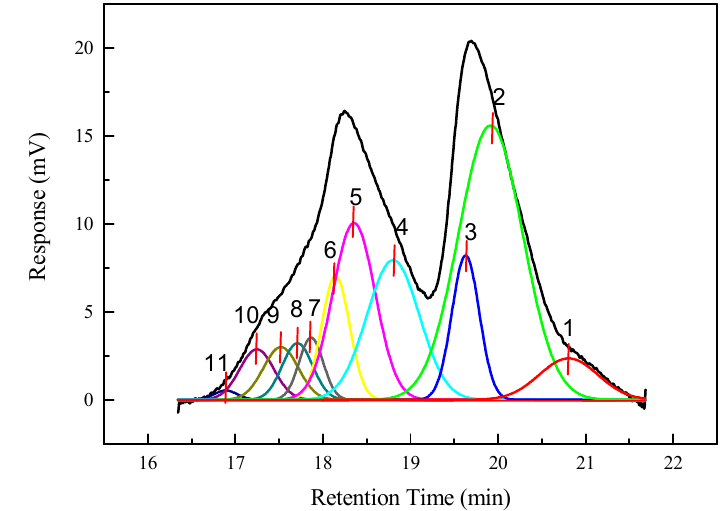
Figure 7. Gas permeation chromatograms of products of chitosan degraded in a combined manner. Table 4. Gas permeation chromatography (GPC) molecular weight analysis a .